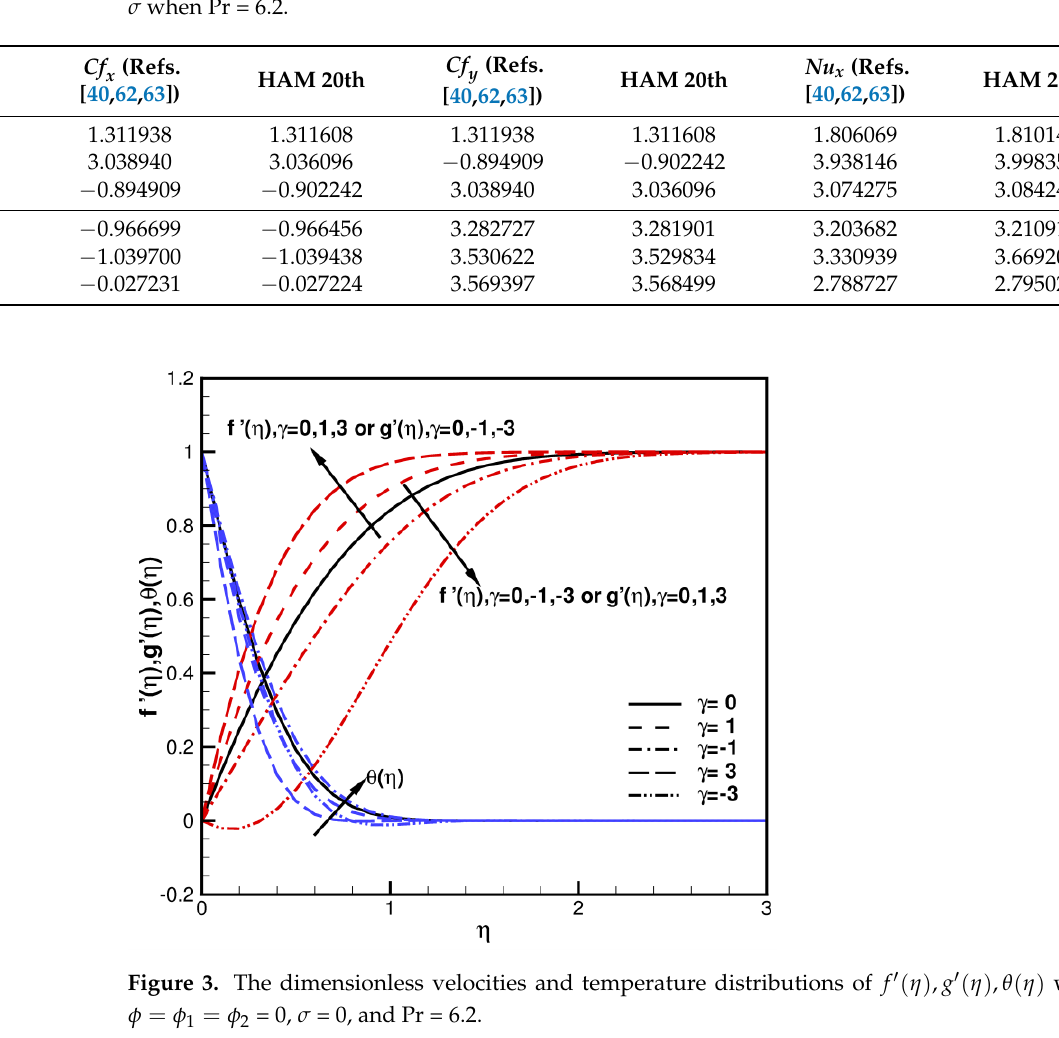
( a ) ( b ) Figure 4. The dimensionless velocities and temperature distributions of ( ) ( ) ( )  ,', ' gf when 21  == = 5% and Pr = 6.2. ( a ) Impact of γ = 0, σ = 0, 2, 5; ( b ) Impact of γ = − 3, 3, σ = 0, 5.